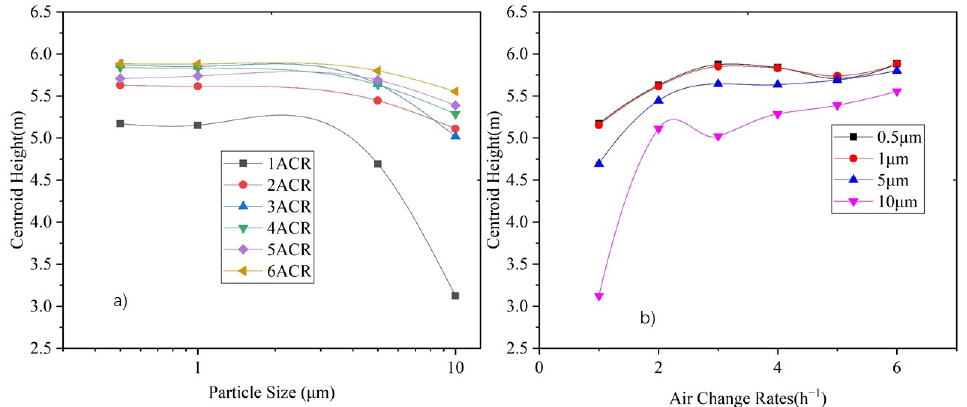
Figure 11. Variation of vertical distribution centroid height under 1 – 6 ACR for each particle size: ( a ) Relationship between centroid height and particle size, and ( b ) relationship between centroid height and air change rate.